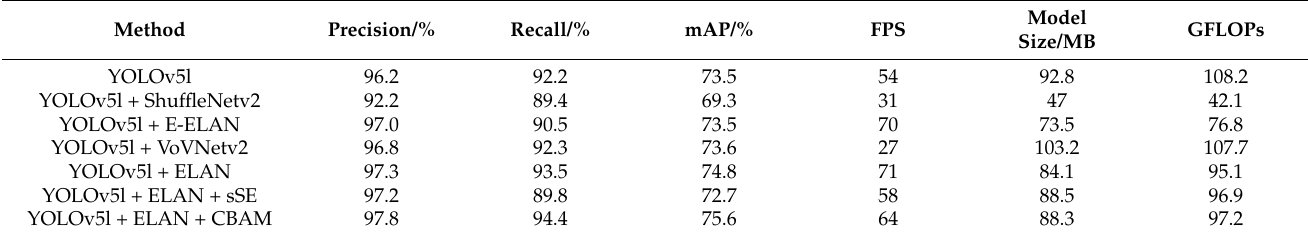
Table 2. Experimental results of different modules on the EgoHands dataset.